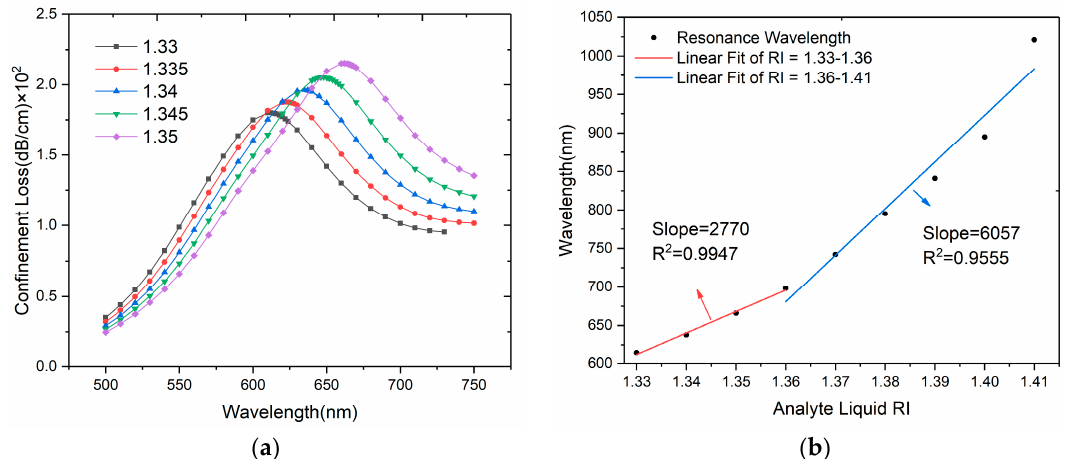
Figure 4. ( a ) Loss spectra of the designed sensor when n a varies from 1.33 to 1.35; ( b ) Relationship between resonance wavelength and RI in the range of n a from 1.33 to 1.41.